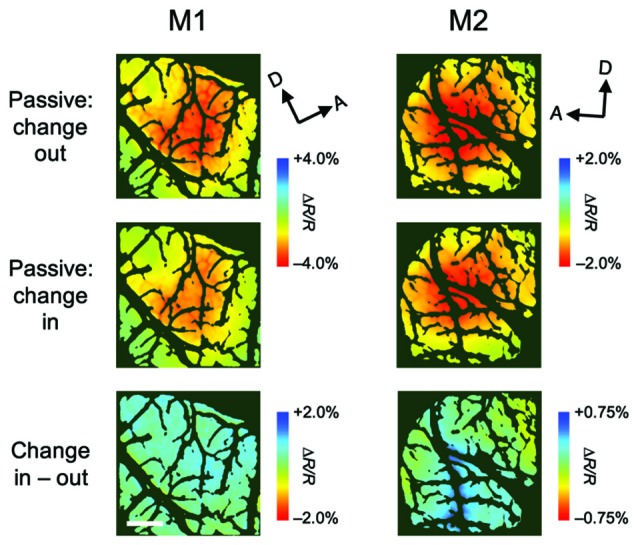
Stimulus-evoked hemodynamic responses in passive viewing conditions. These maps were obtained from a control experiment in which, in alternating blocks of trials, the color of the patch either outside or inside the population receptive field (pRF) of the imaged region changed (change-out and change-in, respectively), as the attention task, but the monkeys only received a reward after fixation without saccades. Therefore, the monkeys were not required to attend to the patches. All conventions are as in Figure 3.